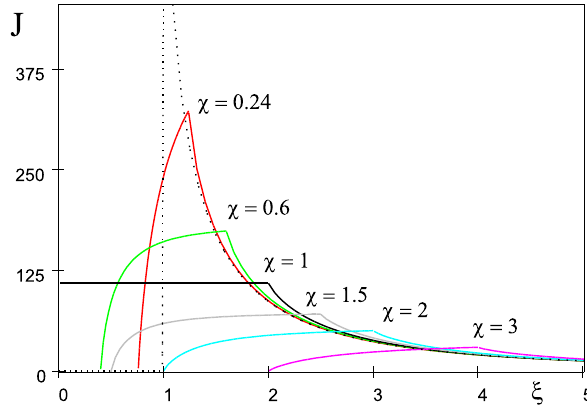
Fig. 2 The plot of J max (χ) = J ( 1 + χ,χ) . This function determines Fig. 3 The form of tails J (ξ,χ) for a set of values of χ . Advanced part of tails corresponds to ξ < 1. For values χ > 2 tails possess only the retarded